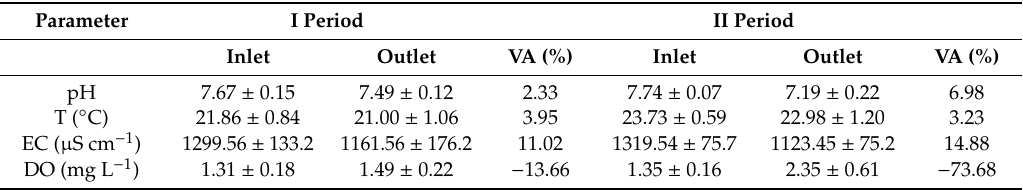
Table 1. Variation (VA) of pH, temperature (T), electrical conductivity (EC) and dissolved oxygen (DO) in the VSSFs CW from October 2018 to July 2019. Average values ( ± standard deviation) are shown ( n = 18).